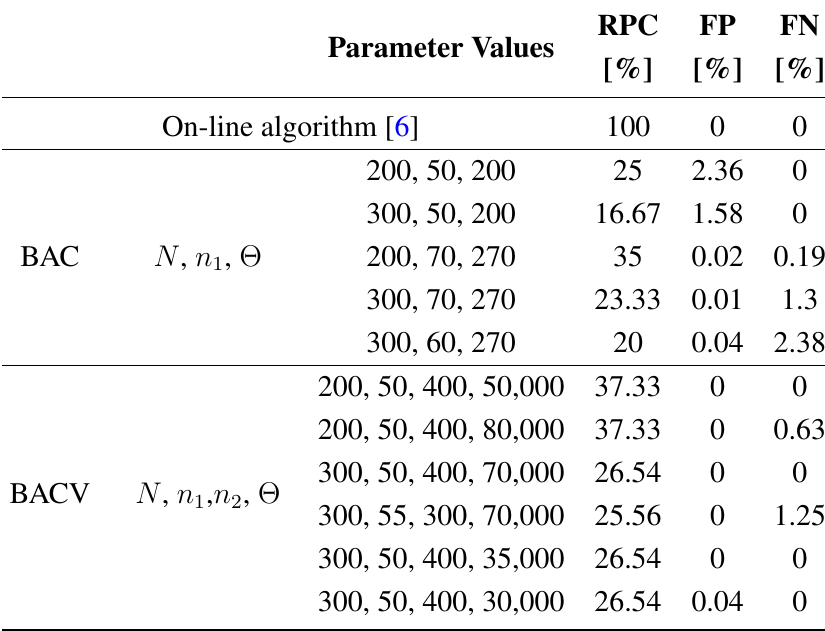
Table 1. Performance comparison of the algorithms. RPC, relative power consumption; FP, false positive; FN, false